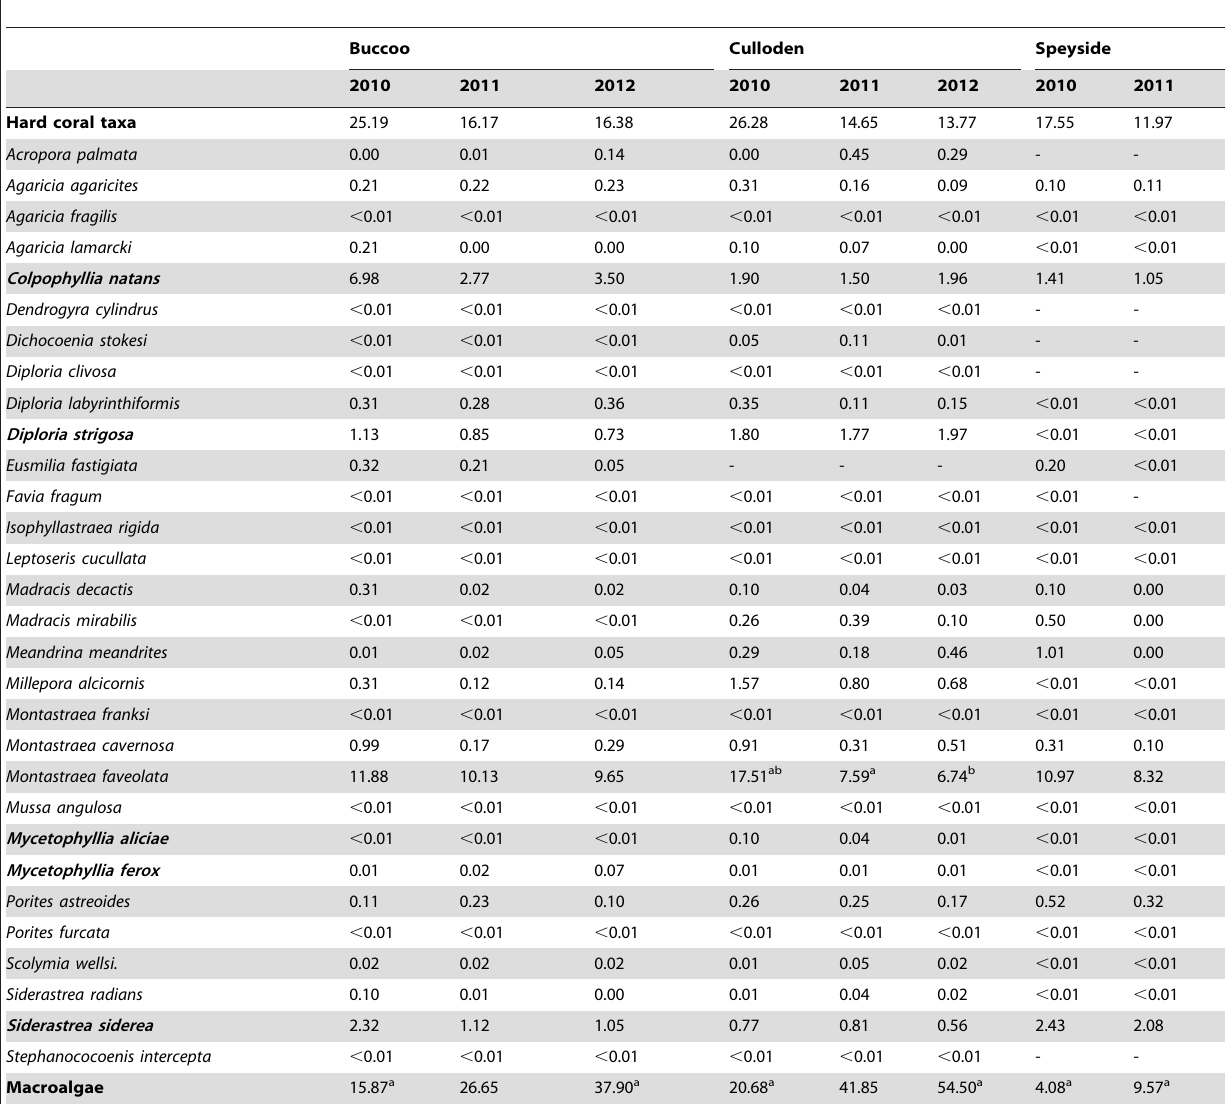
Table 3. Percent change in hard coral and macroalgal cover at Buccoo, Culloden and Speyside one year and two years post 2010 mass